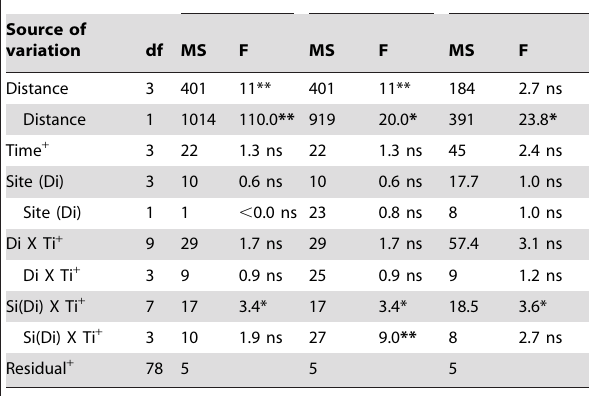
Table 1. Asymmetrical univariate analyses of variance of the number of taxa on panels submerged in different sites in all sampling times.